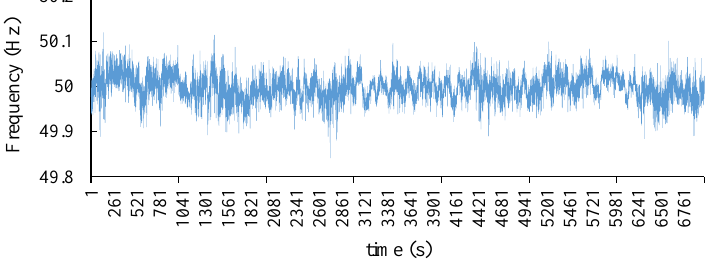
Figure 1. 7000 s real frequency.